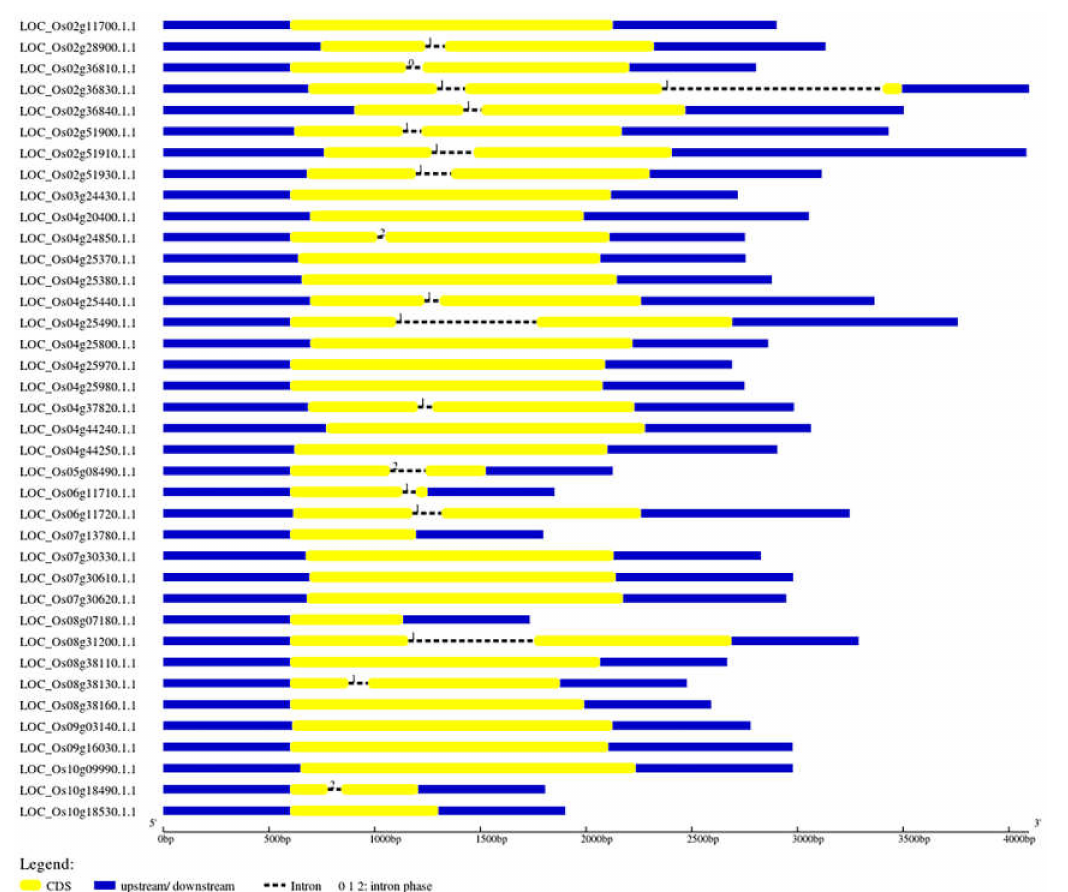
Figure 1. Exon/intron organization of cytokinin-O-glucosyltransferase (CGTs) genes. Yellow boxes rep- resent exons, and black dashed lines with the same length represent introns. The upstream/downstream regions of CGT genes are indicated in blue boxes. The numbers 0, 1, and 2 represent the splicing phase of the intron. The length of exons can be inferred by the scale at the bottom.